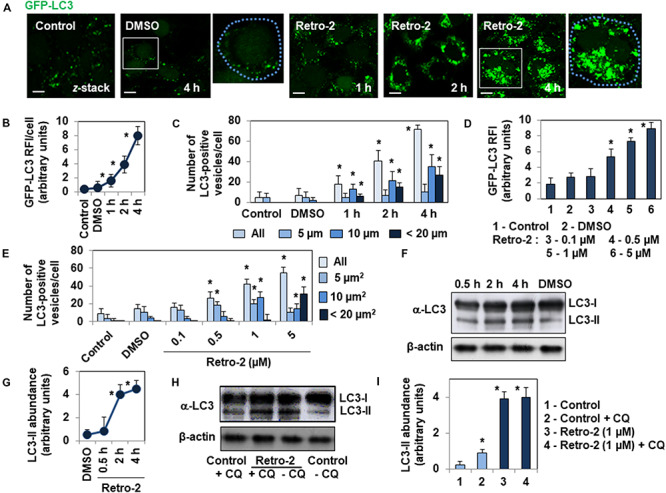
Retro-2 induces autophagy in GFP-LC3-expressing HeLa cells. (A) Representative CLSM micrographs showing the rare presence of GFP-LC3-positive vesicles in control and DMSO-treated cells, and the increase of GFP-LC3-positive vesicles in the cytoplasm of cells treated with Retro-2 (1 μM) during a time-course. (B) Graph showing the increase of the Relative Immunofluorescence Intensity (RFI) of GFP-LC3 per cell in cells treated with Retro-2 (1 μM) during a time-course. (C) Bar graph showing the increase of total, small (5 μm2), large (10 μm2), and very large (<20 μm2) GFP-LC3-positive vesicles in cells treated with Retro-2 (1 μM) during a time-course. (D) Bar graph showing the concentration-dependent increase of the GFP-LC3 RFI/cell in cells treated with increasing concentrations of Retro-2 for 4 h. (E) Quantification of all, small (5 μm2), large (10 μm2), and very large (<20 μm2) GFP-LC3-positive vesicles, showing their concentration-dependent increase in cells treated with increasing concentrations of Retro-2 for 4 h. (F) A representative Western blot showing LC3 processing in control cells and cells treated with Retro-2 (1 μM) during a time-course. β-actin was monitored to ensure equal loading of the lanes. (G) Graph showing the quantification of abundance of LC3-II protein determined by Western-blot analysis, showing the time-dependent increase of the autophagy marker in Retro-2 (1 μM)-treated cells during a time-course. (H) A representative Western blot showing the abundance of LC3-II protein in control cells and cells treated with Retro-2 in the presence, or not, of chloroquine (CQ). (I) Graph showing the quantification of abundance of LC3-II protein determined by Western-blot analysis, showing the equal abundance of LC3-II protein in cells treated with Retro-2 in the presence, or not, of CQ. CLSM micrographs are representative of three separate experiments in duplicate. Scale bar, 10 μm. White boxed regions delineate the areas shown in adjacent high-magnification images. Dotted blue line delineated the cell surface. The Western blots are representative of two or three separate experiments in duplicate. Western blot quantification was performed using ImageJ software. Quantification of confocal images was performed by examining at least 30 cells for each timepoint and condition using ImageJ software. Values represent the average of three separate experiments in duplicate (±SEM). Data were analyzed using the unpaired Student t-test. *P < 0.01 compared to Control (B–E,G,I).